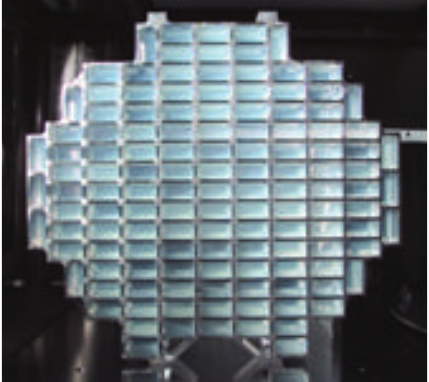
Figure 4: Tennis-racket collector with aerogel (Image courtesy